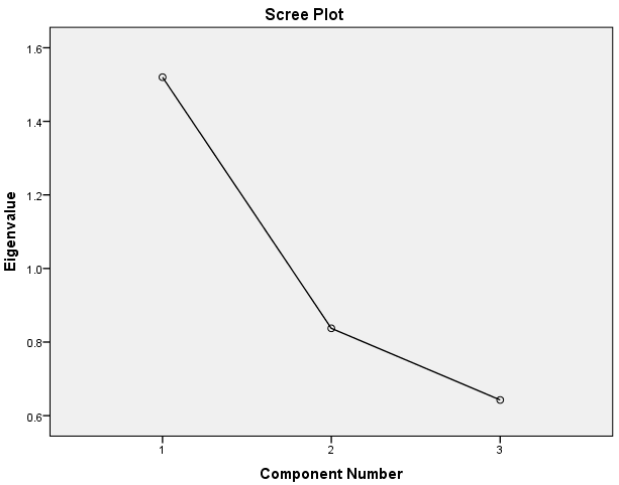
Figure 5. Sedimentation graph of the competence of Teaching. Source: Authors.